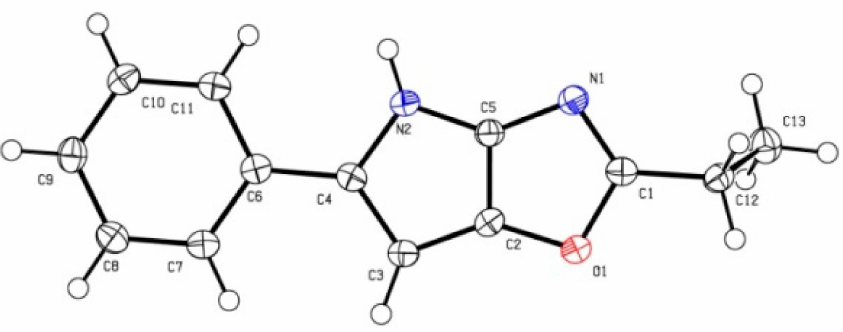
Figure 3. Perspective view of compounds 3d showing thermal ellipsoids at 50% probability